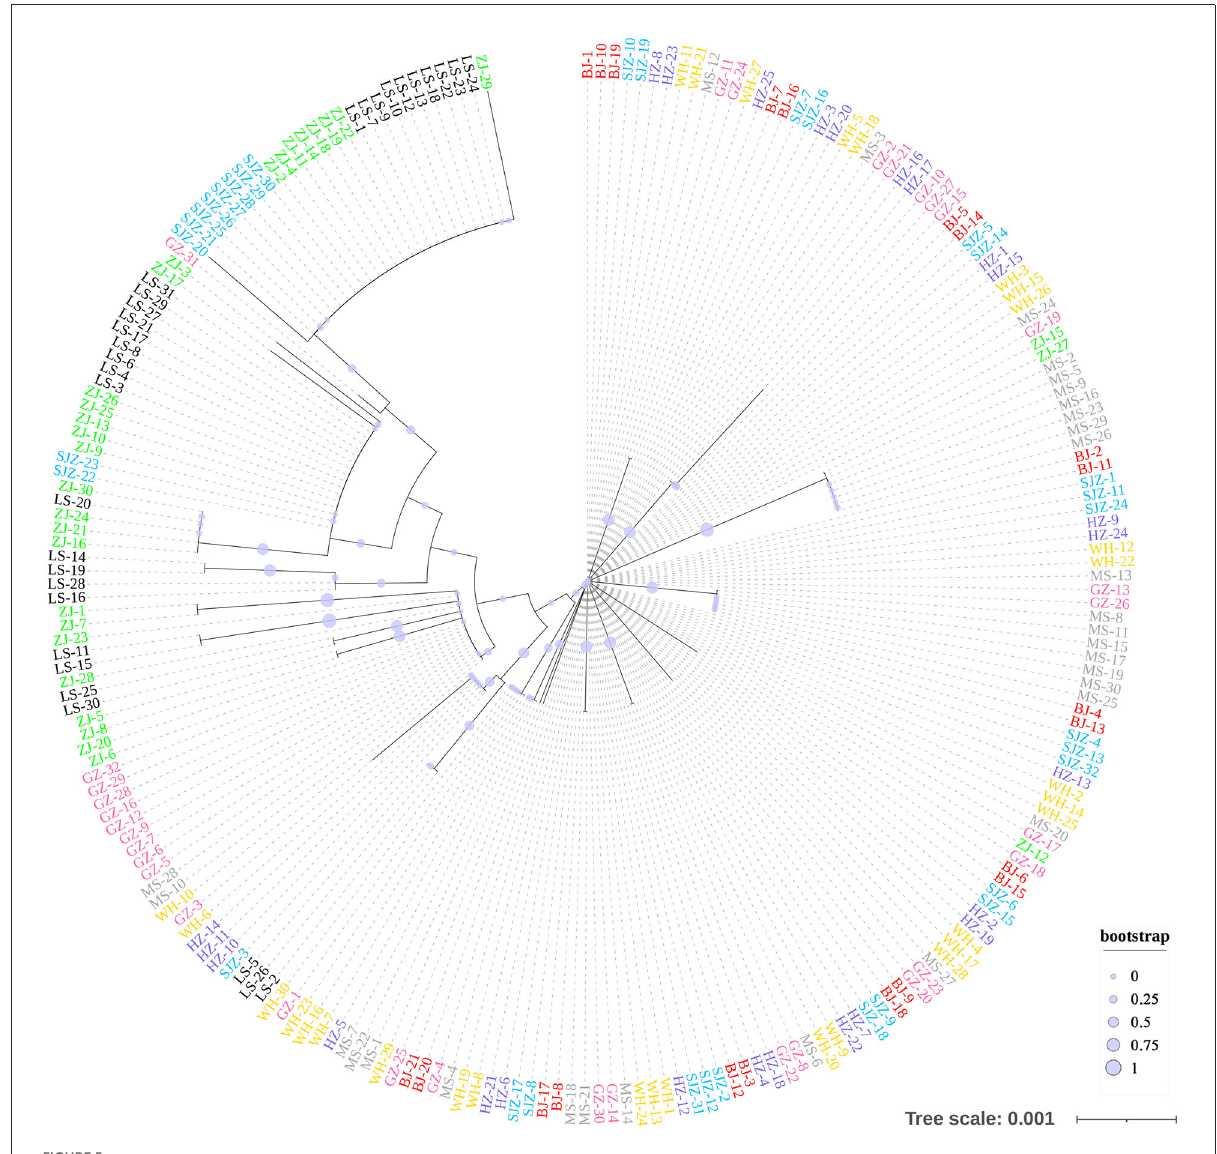
FIGURE5 Neighbor-Joining phylogenetic tree constructed using the cox 1 data.